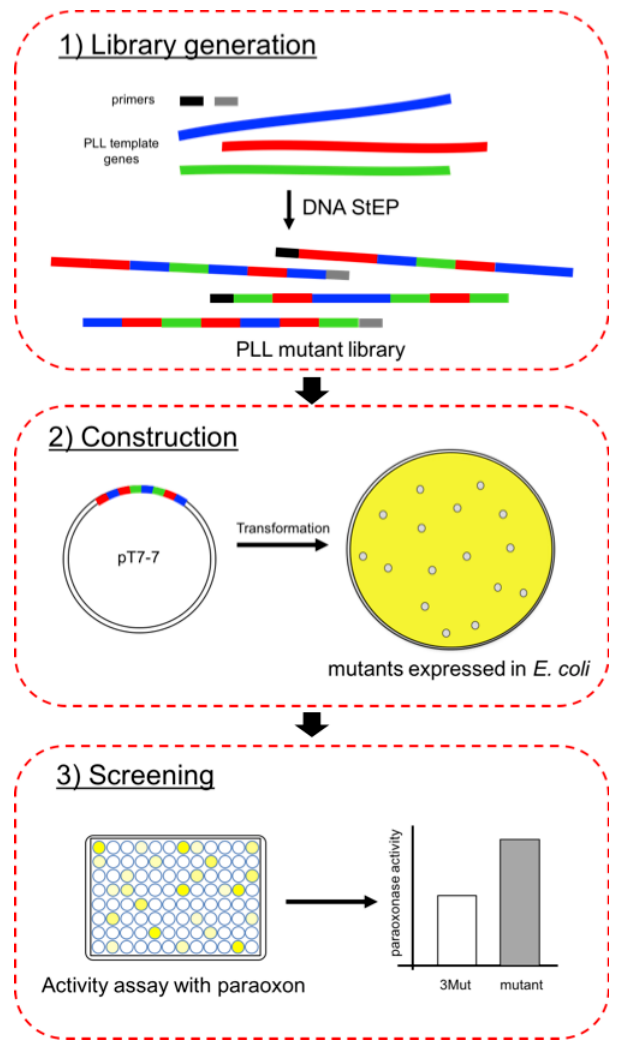
Figure 1. Schematic view of the directed evolution approach used in this work.